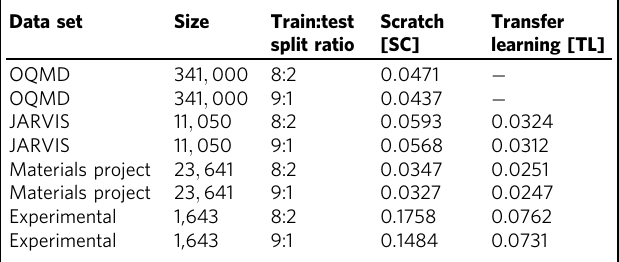
Table 2 Holdout test set performance of the ElemNet models in MAE (eV/atom).